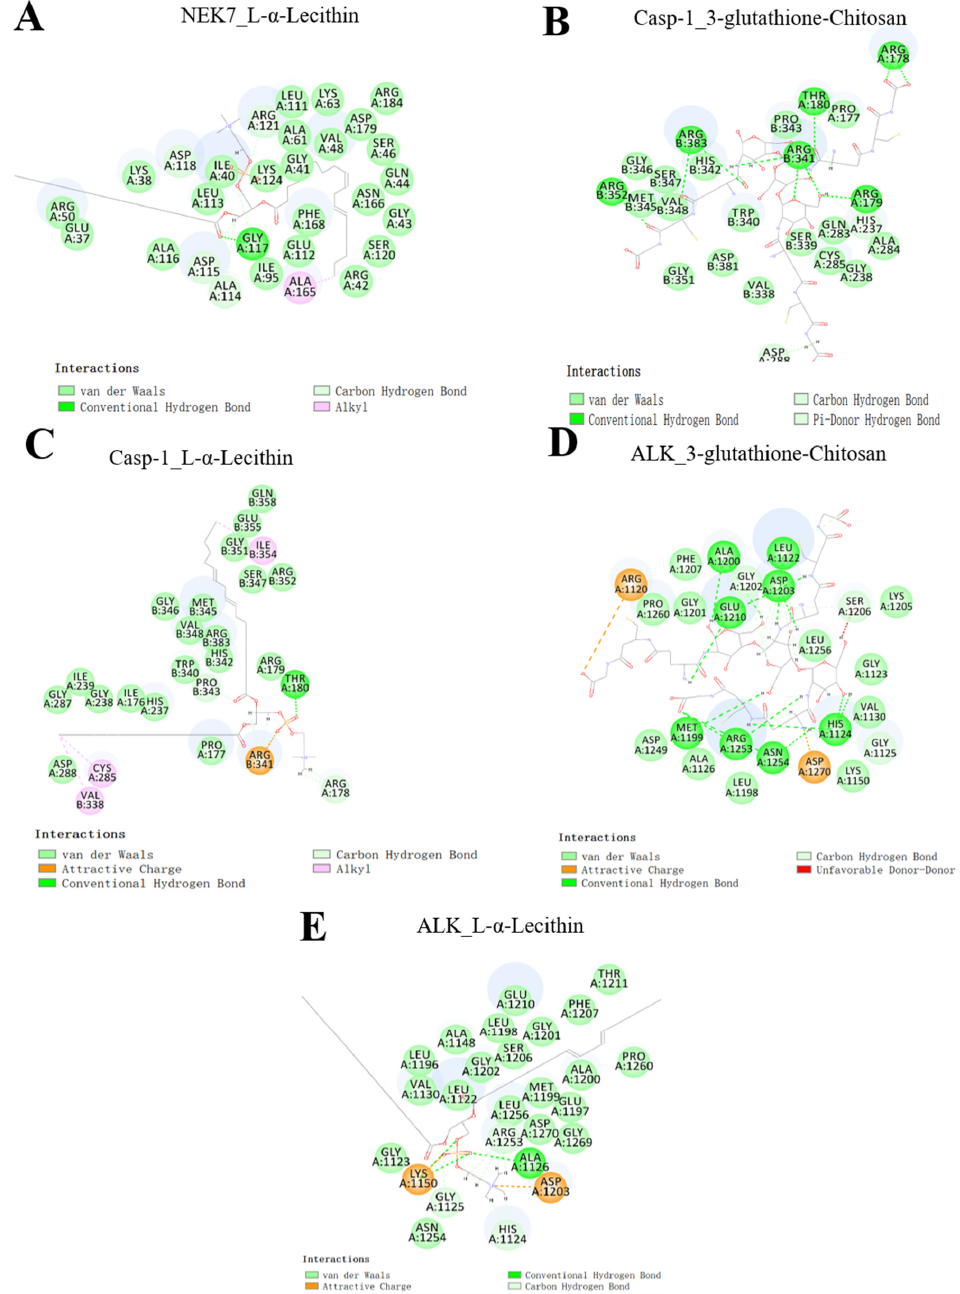
Figure 2. The interaction domain and atoms of the minimum energy docked conformation of components of NLRP3 inflammasome and